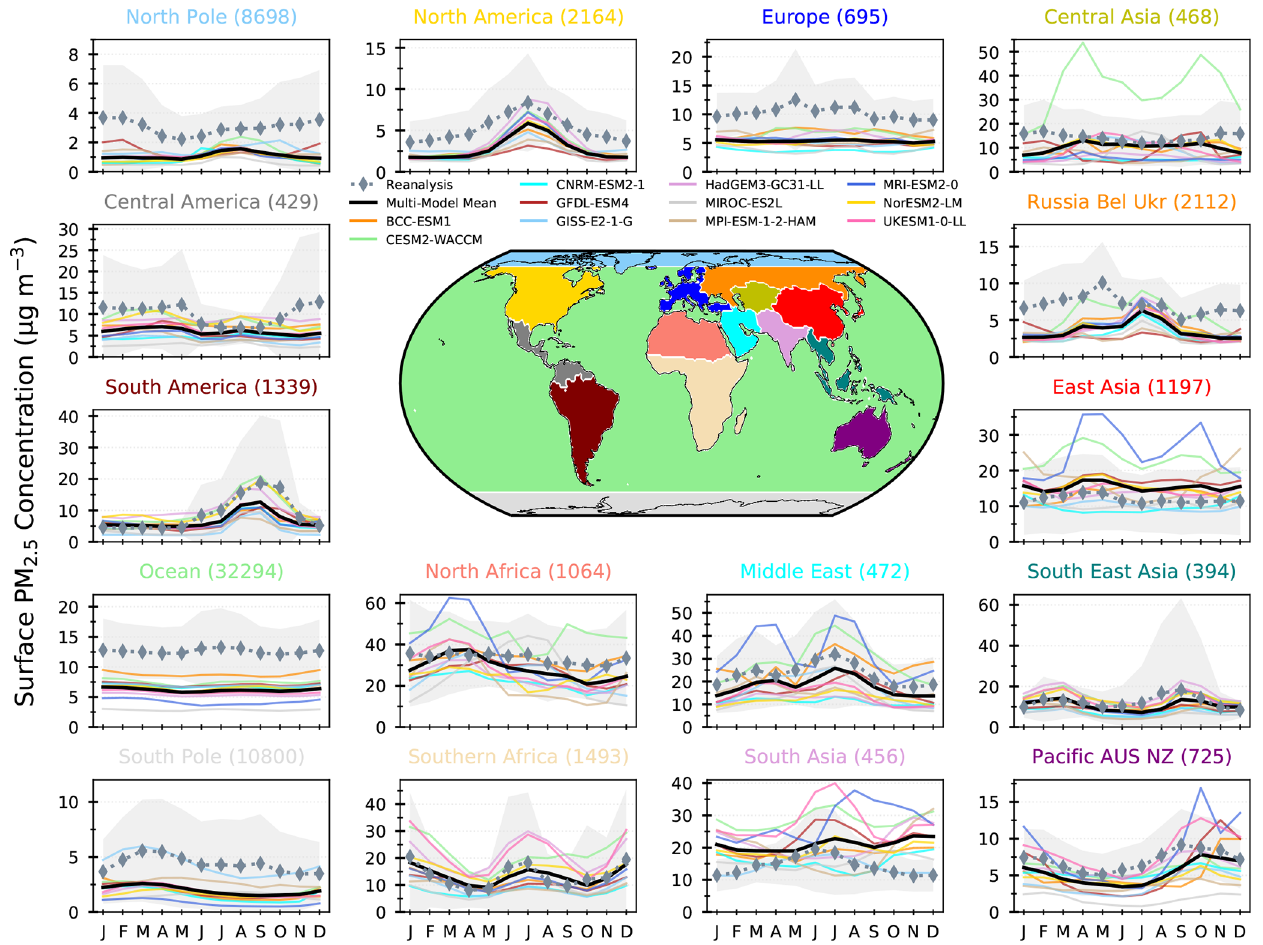
Figure 8. Individual and multi-model (11 CMIP6 models) monthly mean surface PM 2 . 5 concentrations across different world regions com- pared with the regional monthly values from the PM 2 . 5 MERRA-2 reanalysis within the region for the period 2005–2014. The number of reanalysis points within the region is shown in parentheses. The shading shows variability in the values of the MERRA-2 reanalysis products across the